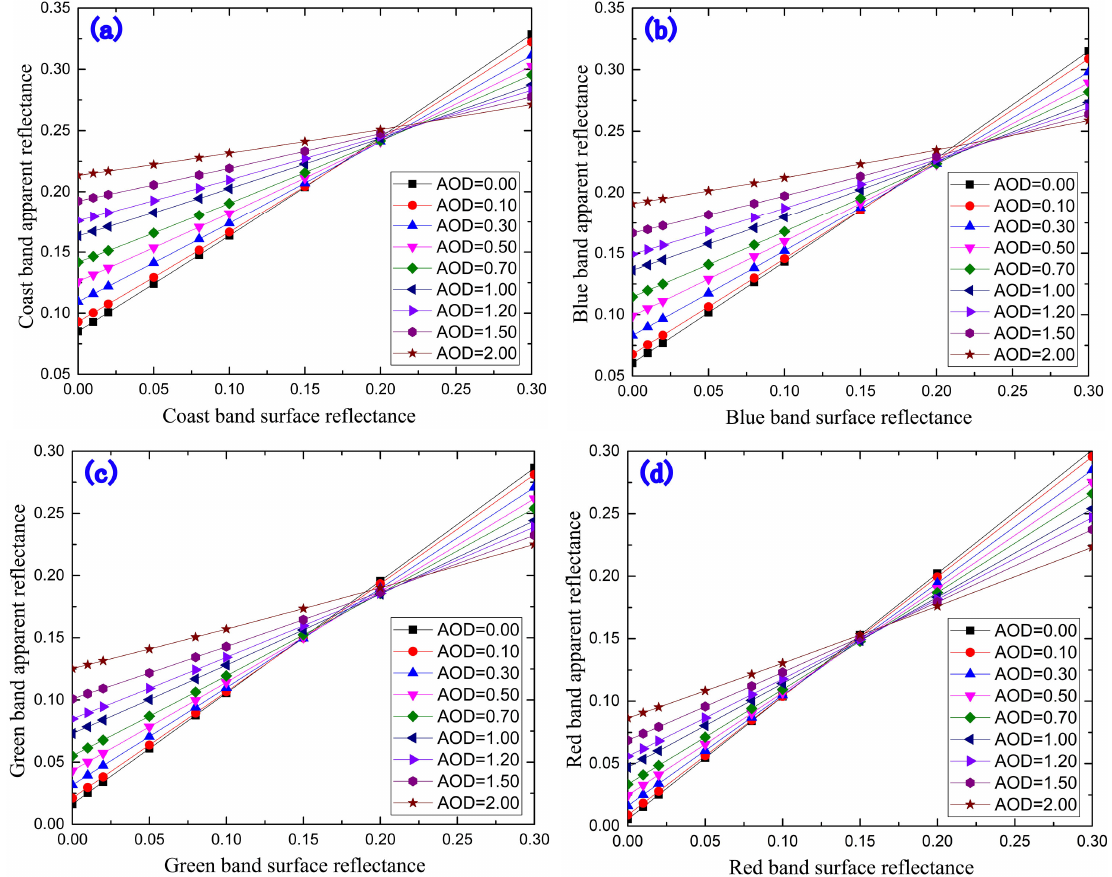
Figure 4. The sensitivity analysis of TOA in different bands (( a ) coast band; ( b ) blue band; ( c ) green band; ( d ) red band) to surface reflectance and AOD.